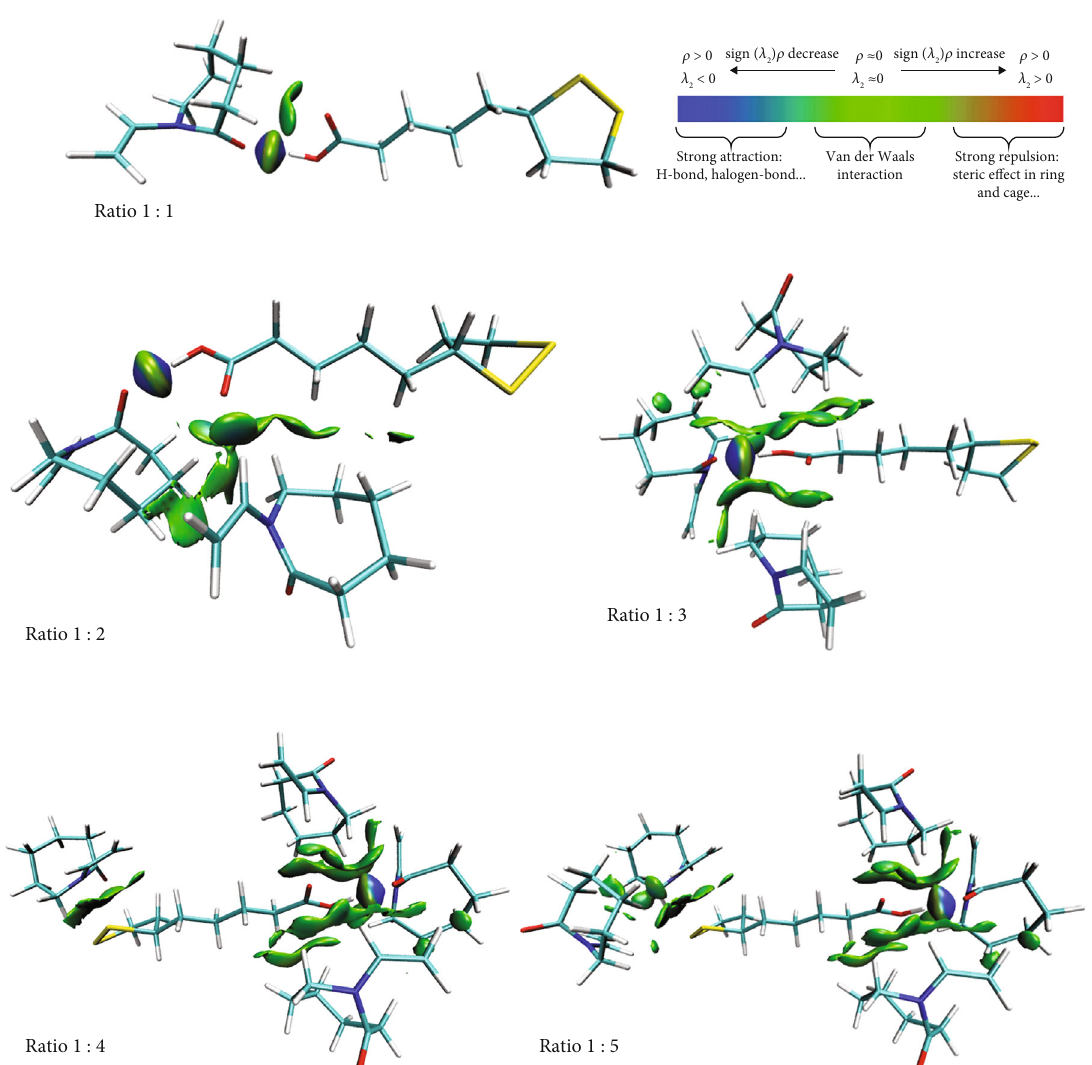
Figure 2: Color scaling of weak interaction of template-monomer mixture.